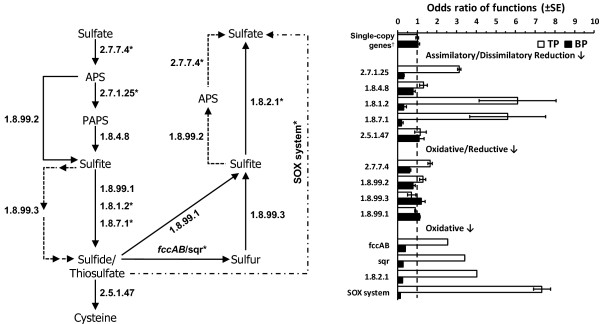
Enrichment of enzymes in the sulfur metabolic pathway. Diagram with the enzyme classification (identified by their Enzyme Commission number; EC number) for each step in the sulfur pathway. Asterik (*) indicate components that are significantly different between the two samples (q < 0.05) based on the Fisher’s exact test using corrected q-values (Storey’s FDR multiple test correction approach) (Table 2). Bar chart shows the odds ratio values for each function. An odds ratio of 1 indicates that the community DNA has the same proportion of hits to a given category as the comparison data set [24]. Housekeeping genes: gyrAgyrBrecArpoA and rpoB. Error bars represent the standard error of the mean.